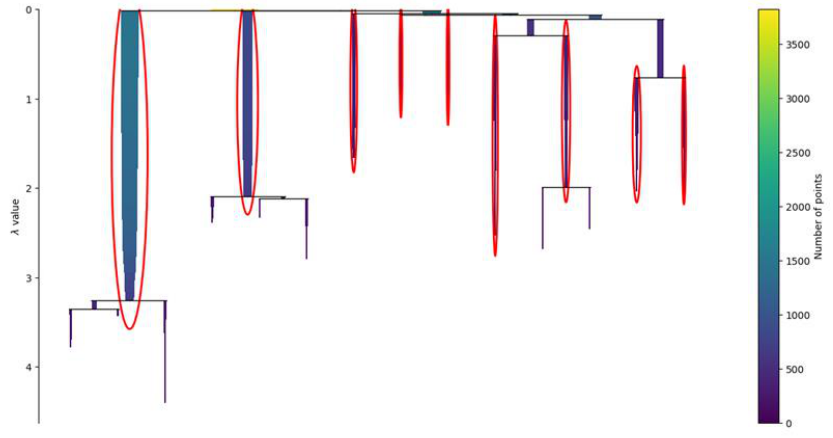
Figure 6. Condensed tree. The condensed tree provides a view of the behavior of the clustering algorithm. In the ordinate, the parameter lambda represents the inverse of epsilon, defined as the maximum distance between two samples, where one sample is considered as being in the neighborhood of the other. The root of the hierarchy is where the value of lambda is small, which means that the epsilon distance is wide. In this area, the identified clusters are larger since the definition of neighbor is wider. Once lambda increases and epsilon decreases, the clusters are sliced into smaller clusters. Usually, a robust clustering is considered the one that persists despite the large variations of lambda. The clusters circled in red are the nine ones selected by the algorithm and are the ones with higher persistence.